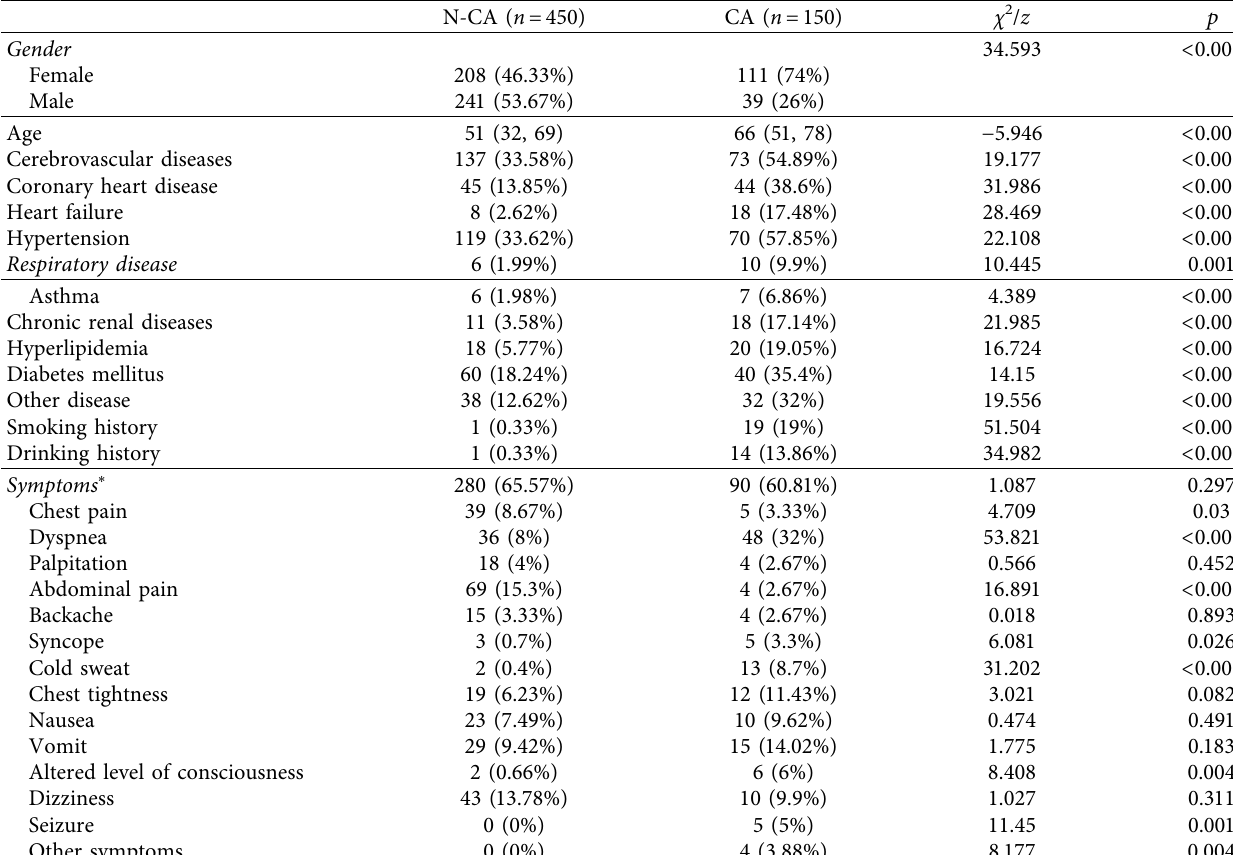
Table 2: Epidemiological and clinical characteristics of the study patients.